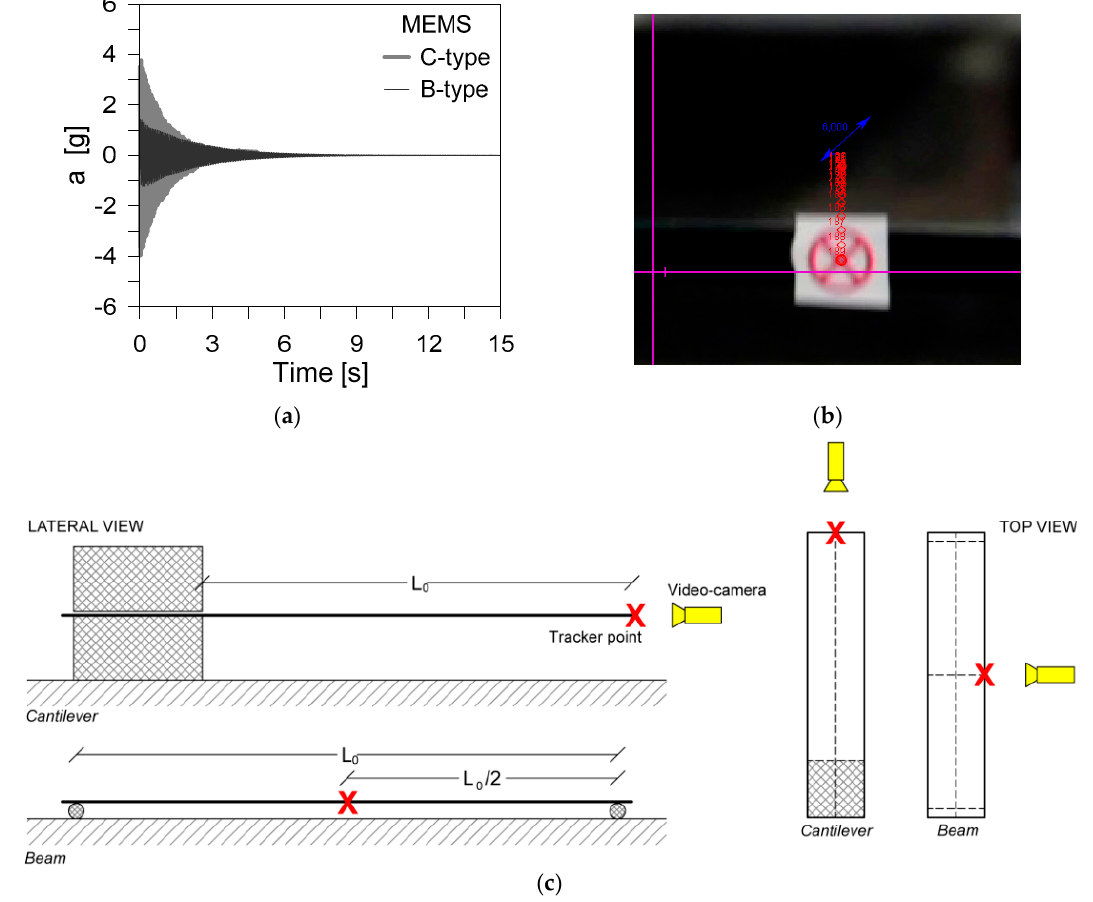
Figure 4. Acquisition of vibration test measurements. ( a ) Example of acceleration-time history by MEMS devices, and ( b , c ) based on Tracker video recording.